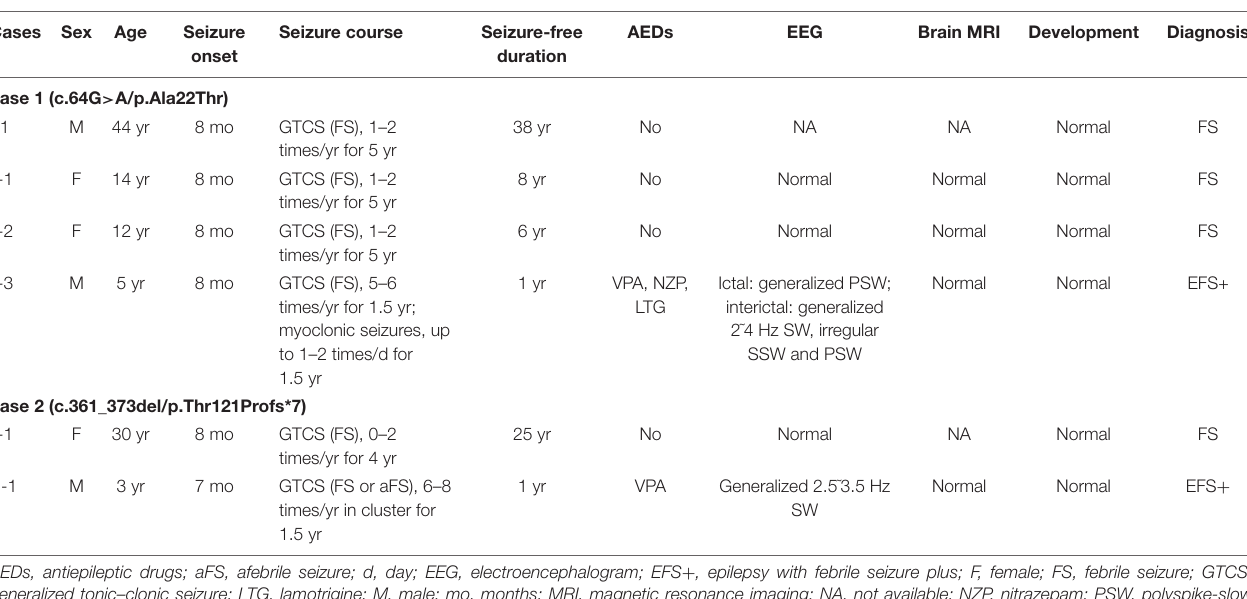
TABLE 2 | Clinical features of individuals with ATP6V0C